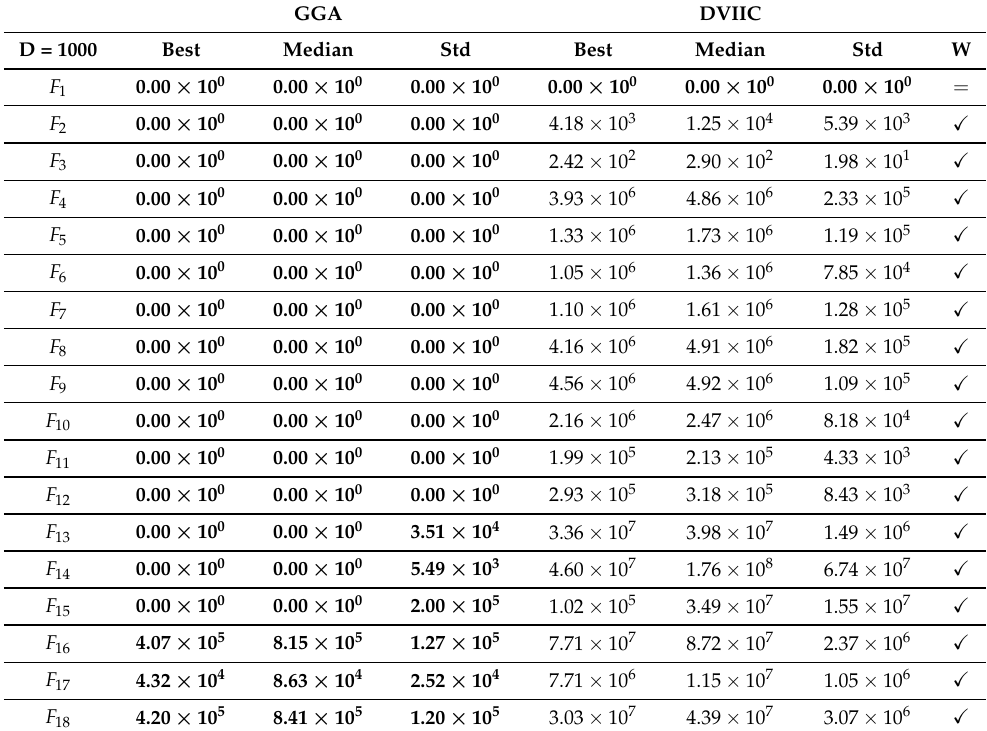
Table 5. Statistical results in dimension 1000. Best results shown in boldface. GGA DVIIC D = 1000 Best